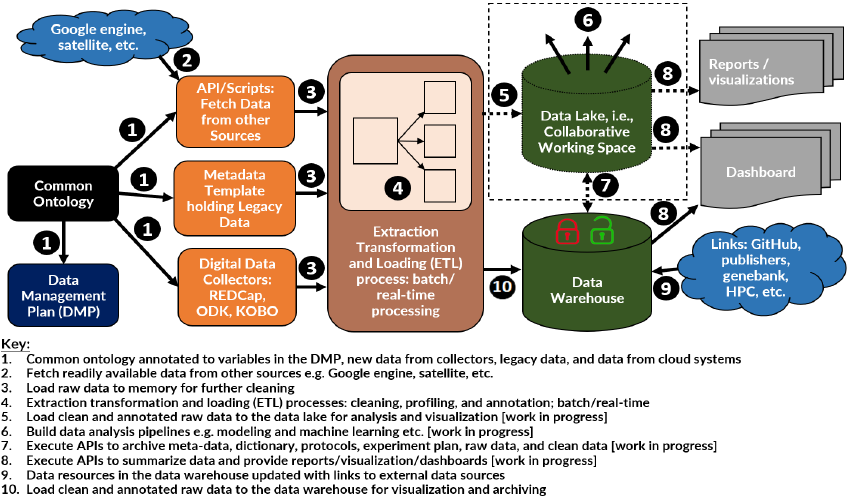
Figure 2. Data and software engineering